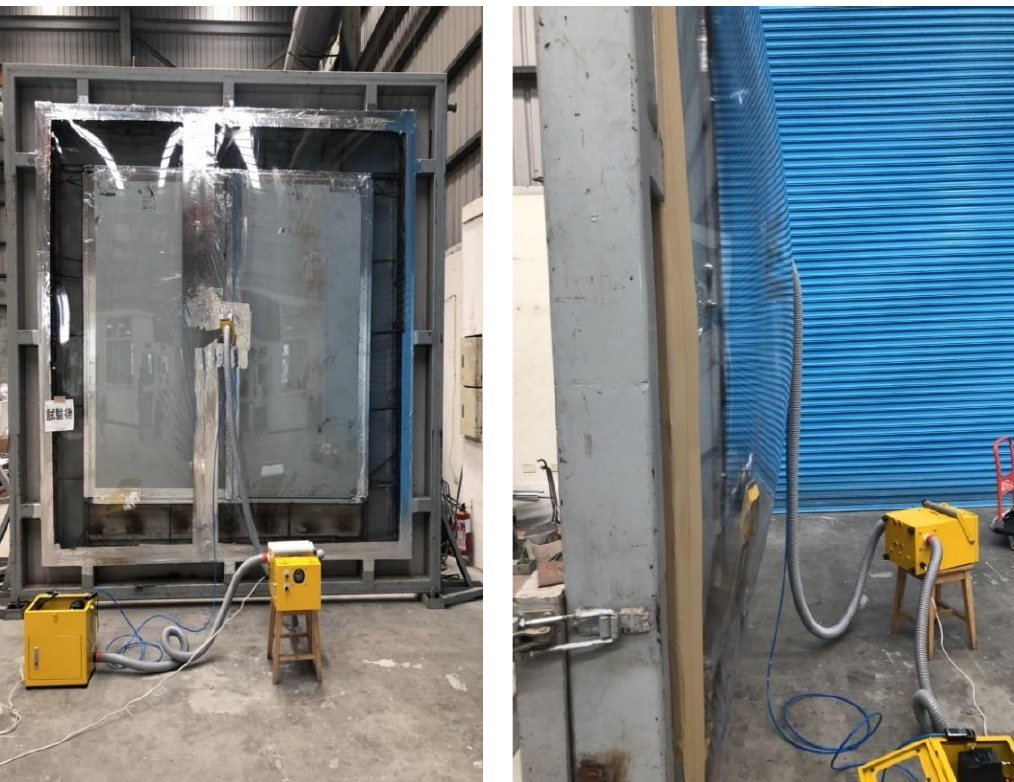
Figure 4. Smoke control field test method verification.